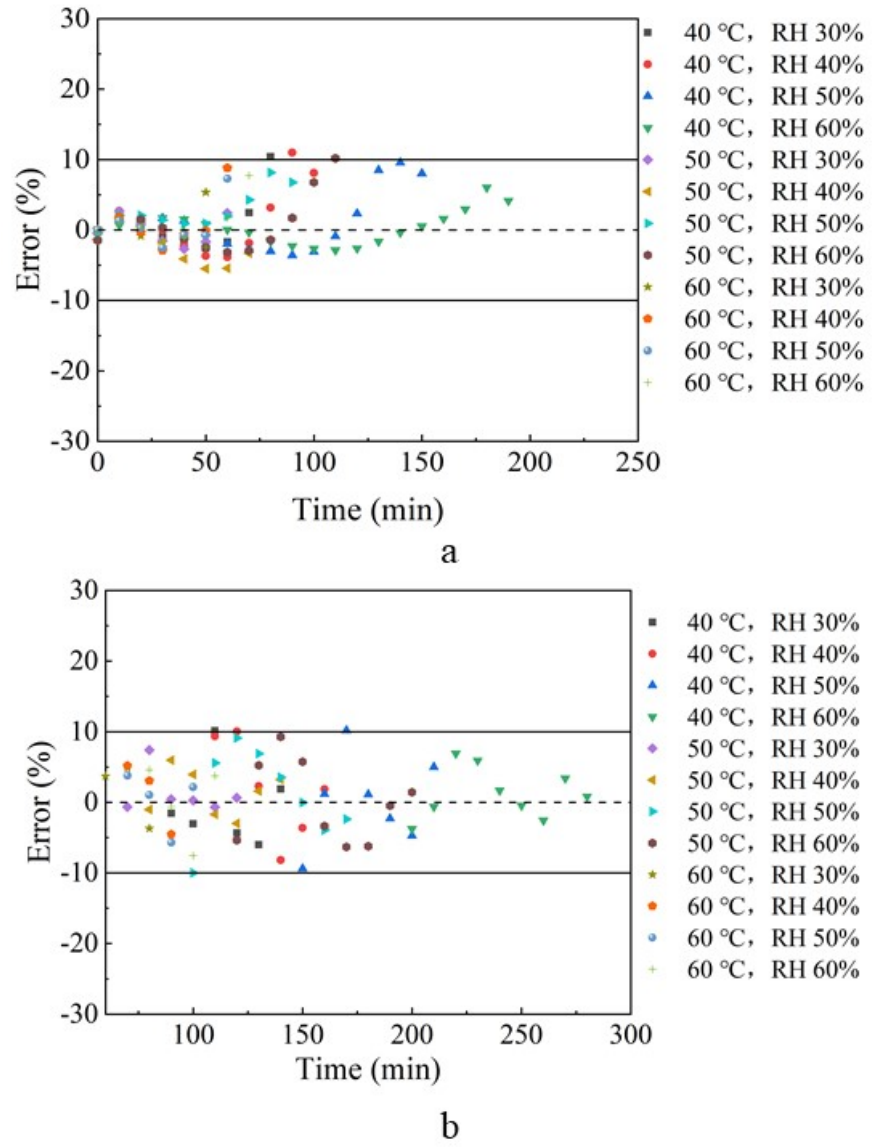
Figure 8. Relationship between the modelled and experimental MR errors under different conditions ( a ) the first stage ( b ) the second stage over time.